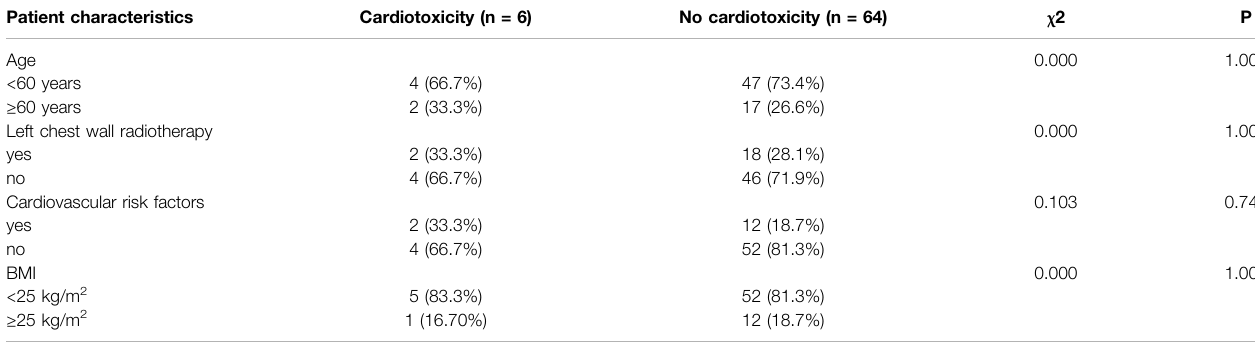
TABLE 4 | Univariate chi-square analyses for in fl uencing factors of clinical cardiotoxicity according to patients ’ characteristics. Patient characteristics